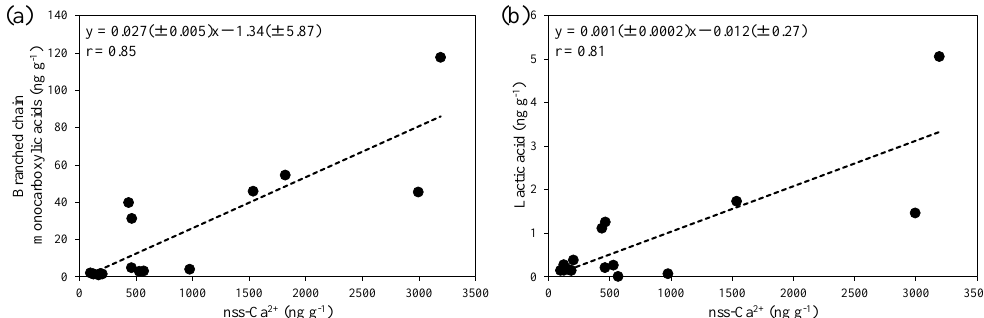
Figure 10. Scatter plots of (a) concentrations of branched chain (iC 4 –iC 6 ) monocarboxylic acids vs. nss–Ca 2 + and (b) lactic acid vs. nss–Ca 2 + in Mt. Tateyama snow samples. The dotted line represents the Deming linear